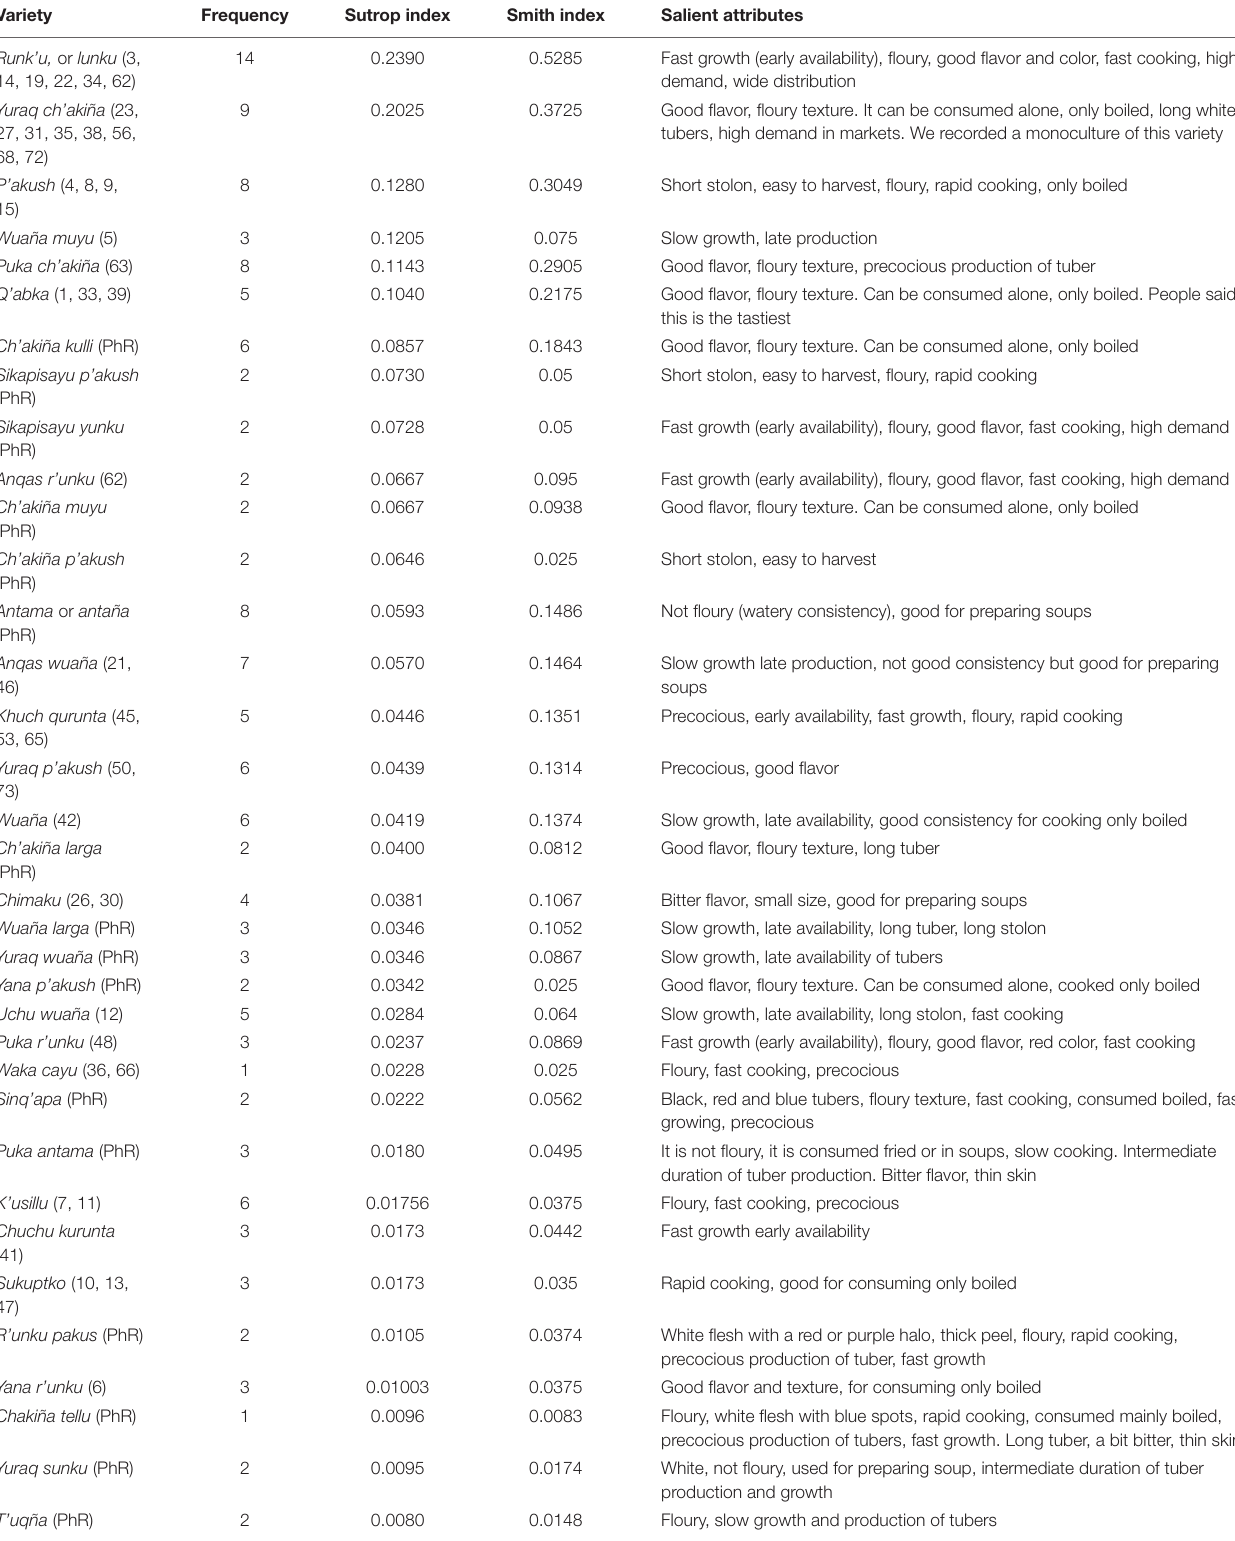
TABLE 2 | From top to bottom, the most salient araq papa varieties mentioned by 67 persons and found in the chacras sampled ( n = 20) and their attributes.